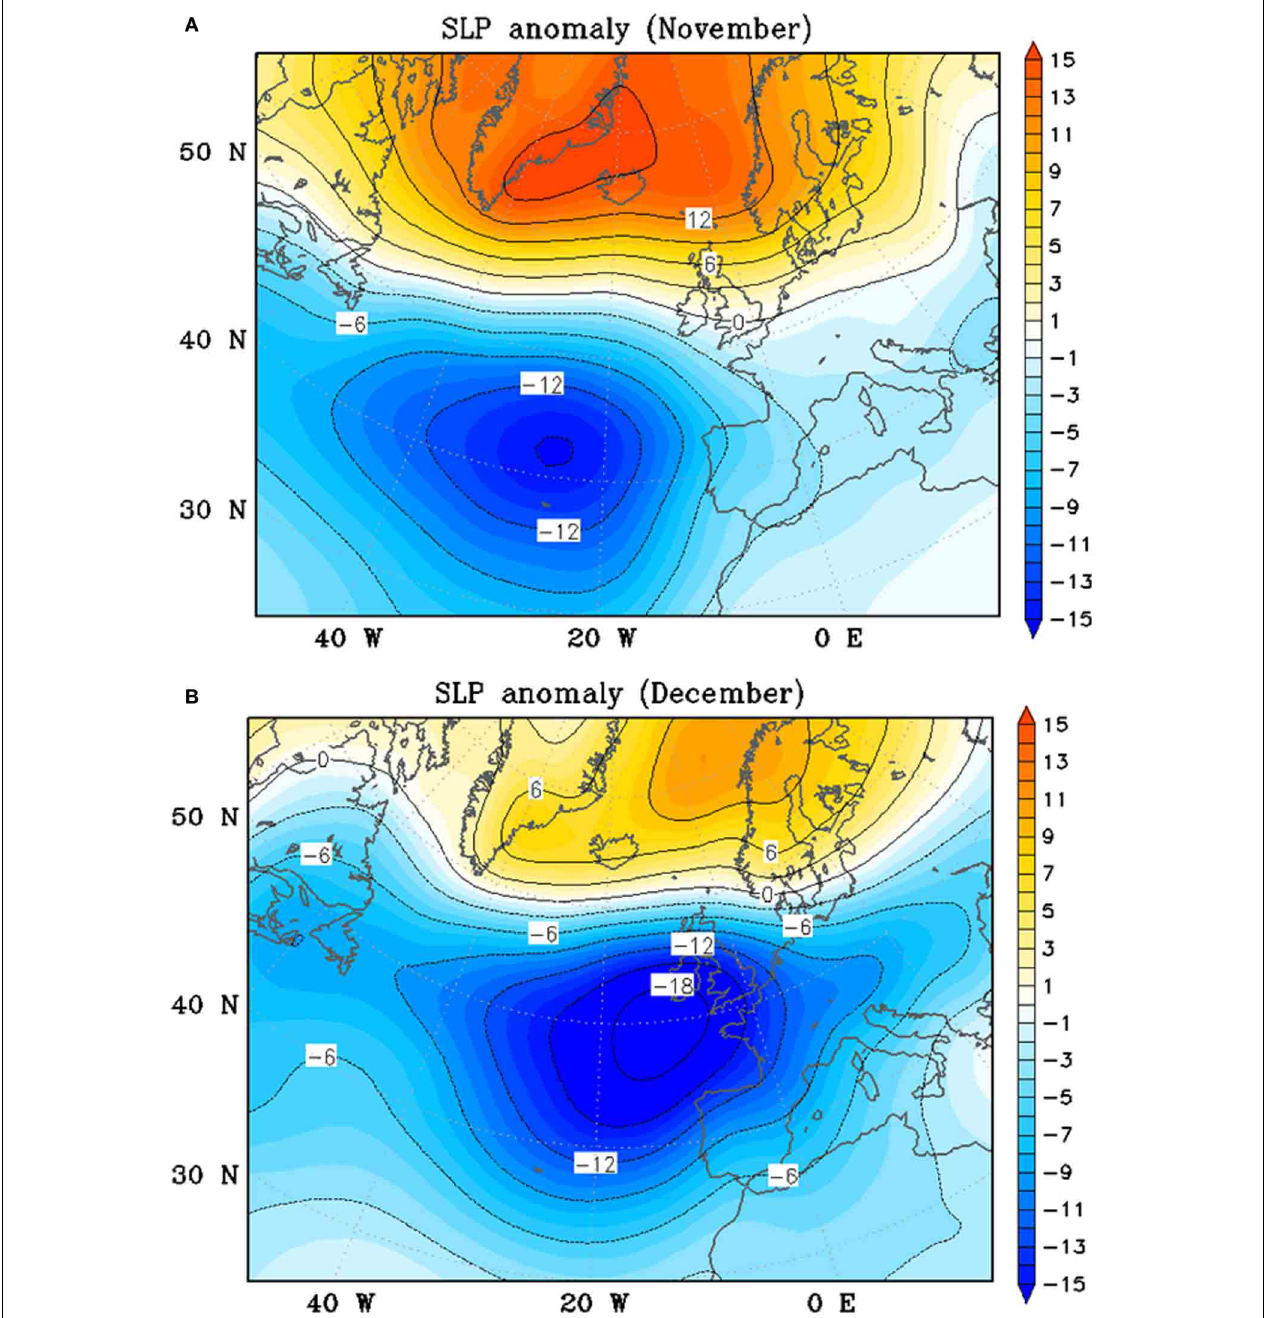
low over the ocean moving northeast while the low pressure system moved in the same direction at surface (Nieto et al., 2005); (2) The second pulse, started on 2 December, with a new air frontal system mass, that had developed over the Atlantic ocean and reached the western IP ( Figure 11 ). In this occa- sion, the pulse is more enduring and remains over